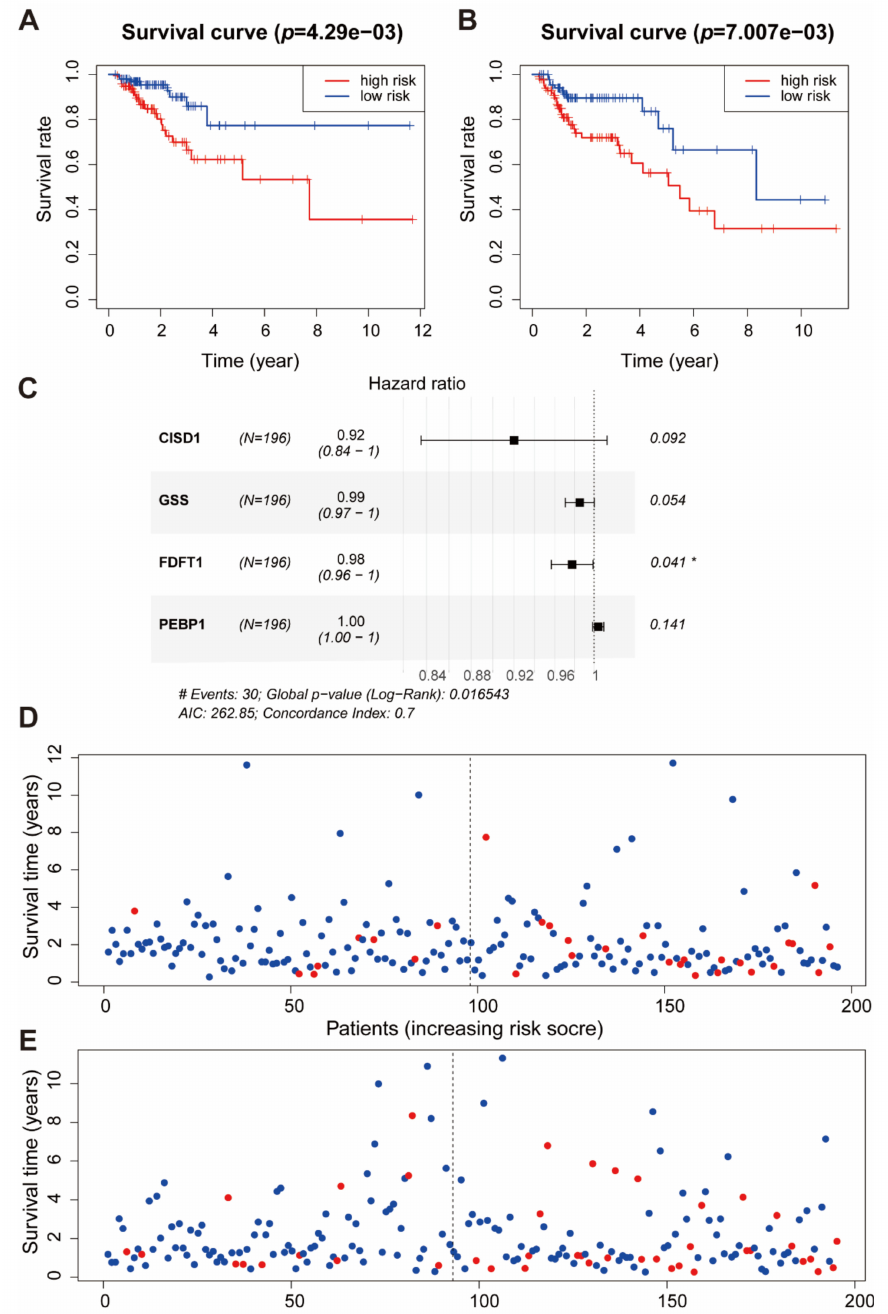
Figure 5. Cox regression model results in TCGA. ( A ) The survival curves of the ferroptosis risk score in the training set. Grouping was based on the median ferroptosis risk score in the training set. Red is the high-level group, and blue is the low-level group. ( B ) The survival curves of the ferroptosis risk score in the test set. Red is the high-level group, and [8] blue is the low-level group. Grouping was based on the median ferroptosis risk score in the training set. ( C ) A forest plot of the multivariate Cox regression model. Hazard ratio is provided in the figure (* p < 0.05). ( D ) Patients’ survival status in the training set. The x-axis is the patient ranking in ascending order by the ferroptosis risk score; the y-axis is the survival time. The red dots represent the patients who died, and the green dots represent the surviving patients. ( E ) Patients’ survival status in the test set. The x-axis is the patient ranking in ascending order by the ferroptosis risk score; the y-axis is the survival time. The red dots represent the patients who died, and the green dots represent the surviving